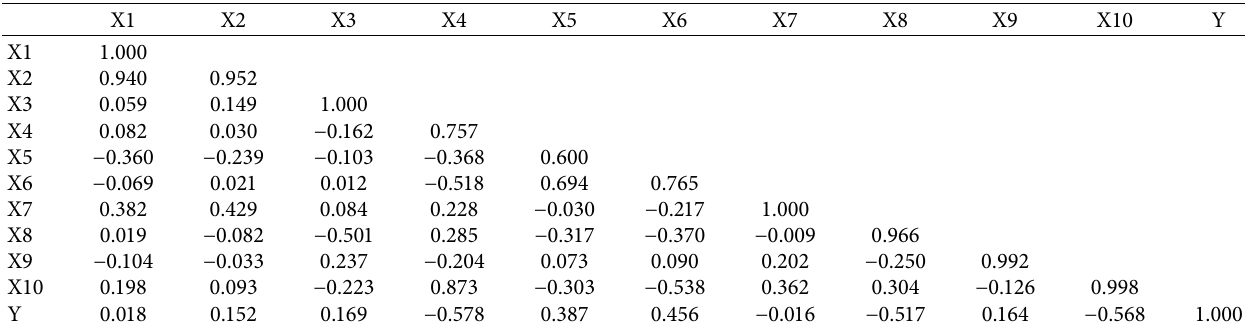
Table 4: Fornell–Larker criterion